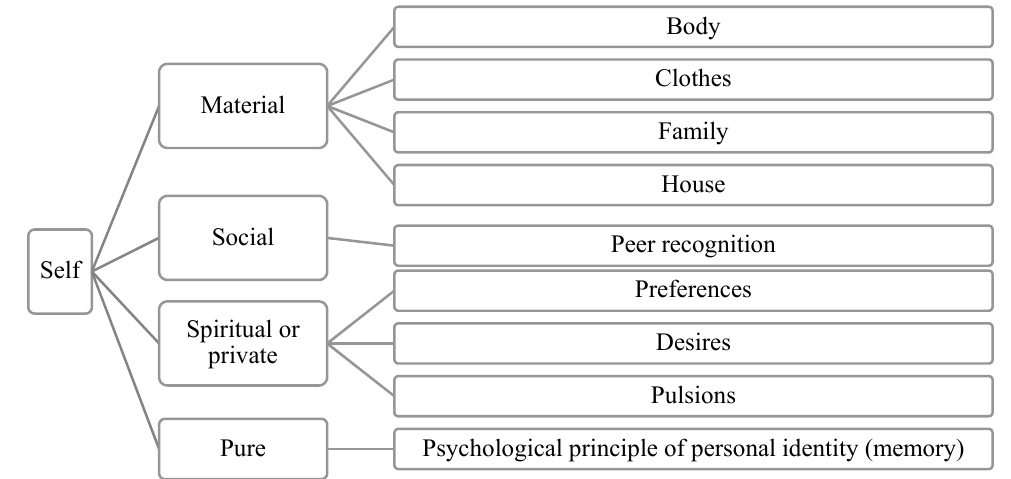
Figure 1. Structure of the self, according to William James (personal elaboration).